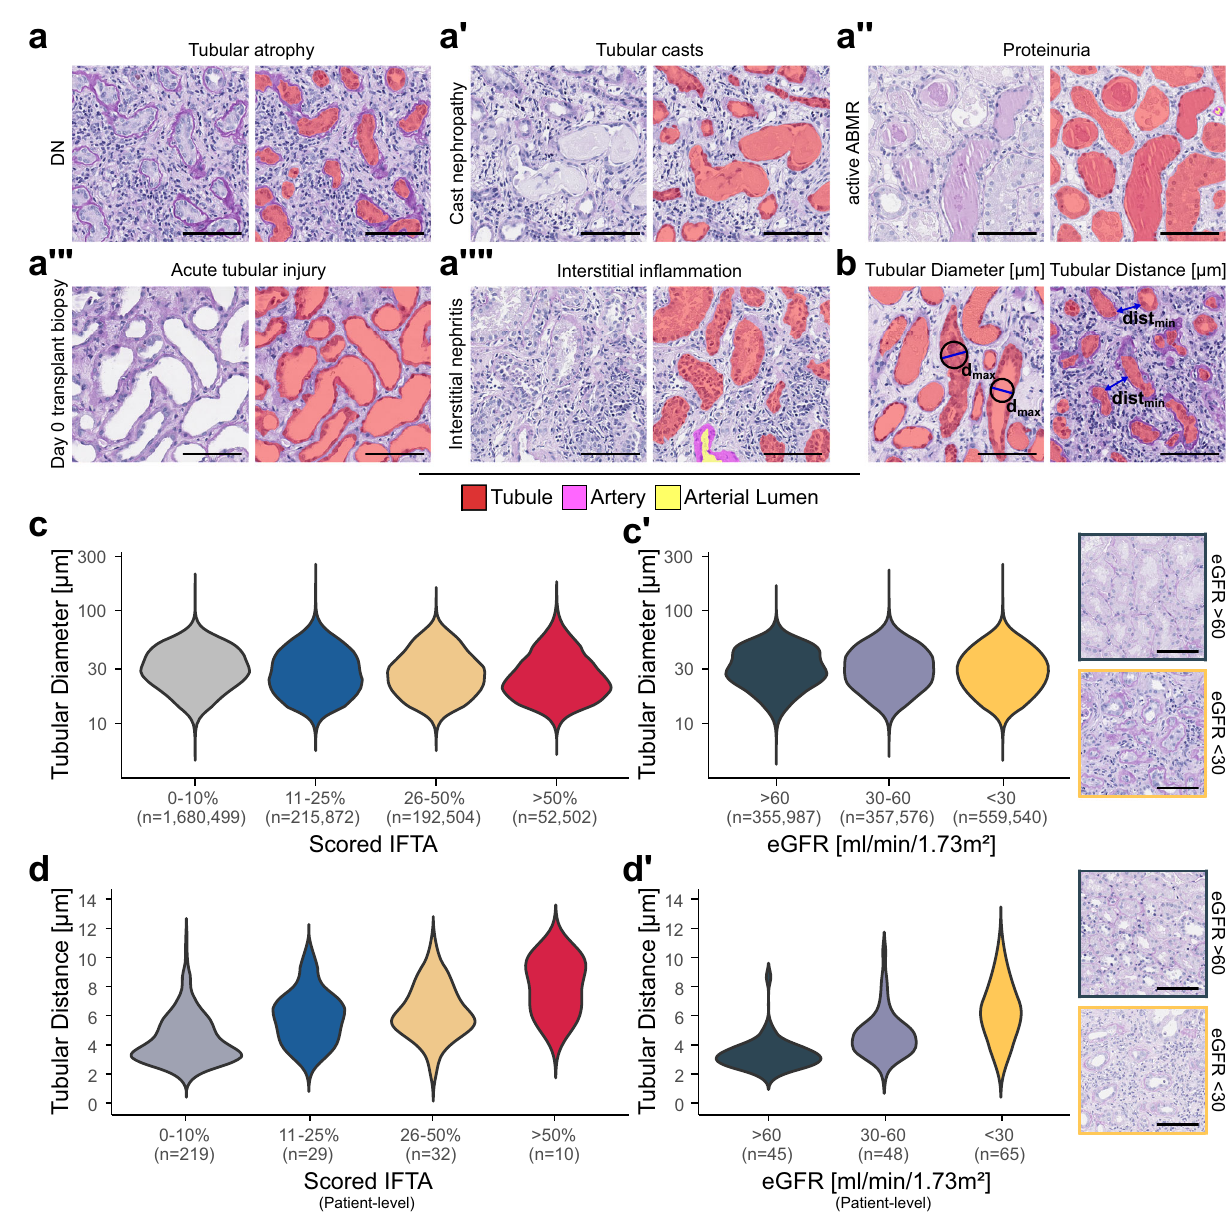
Fig. 3 | NGM-derived features of tubules and arteries are associated with pathologist derived scoring. a – a ″″ Segmentation visualisations of tubules with large variation in size and shape in various diseases and morphological injury patterns present in the patch. Visualisations stem from the internal AC_B cohort excludingtrainingsamples. b Visualrepresentationoffeaturecalculationoftubular diameter and tubular distance. c Feature analysis of tubular diameter on instance- level based on the quanti fi ed amount of interstitial fi brosis and tubular atrophy (IFTA)ofallbiopsieswithreportedIFTAfromthe AC_B cohort. c ′ Analysisoftubular diameter on instance-level based on the measured estimated glomerular fi ltration